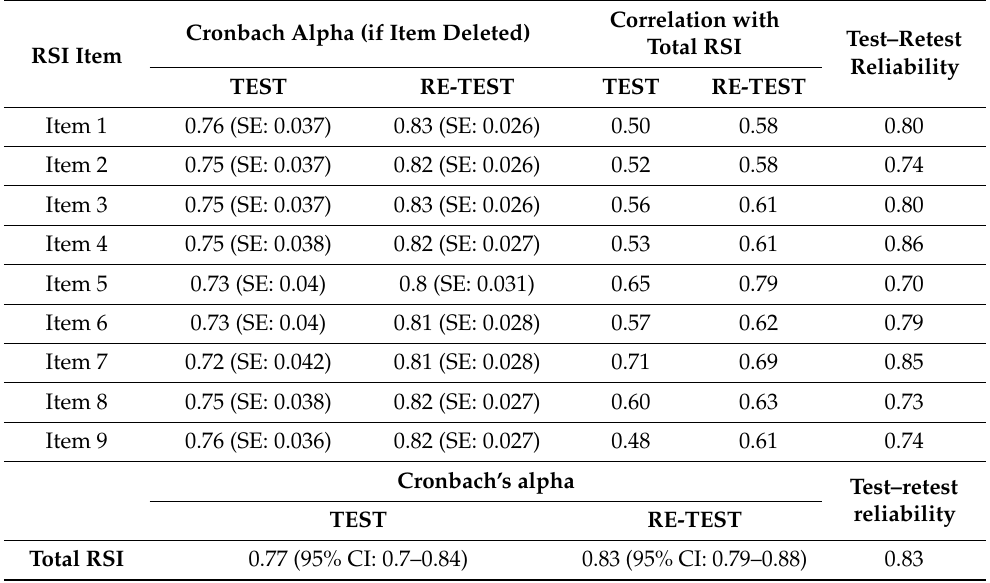
Table 5. Reliability of the PL-RSI